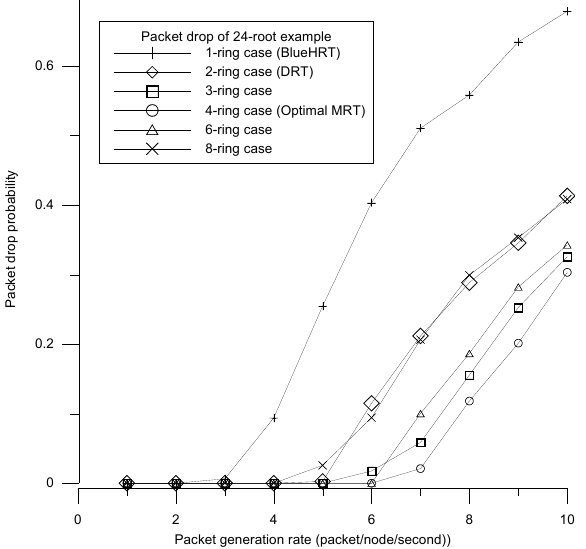
Figure 9. Packet drop probability of the Optimal MRT, DRT, and BlueHRT.